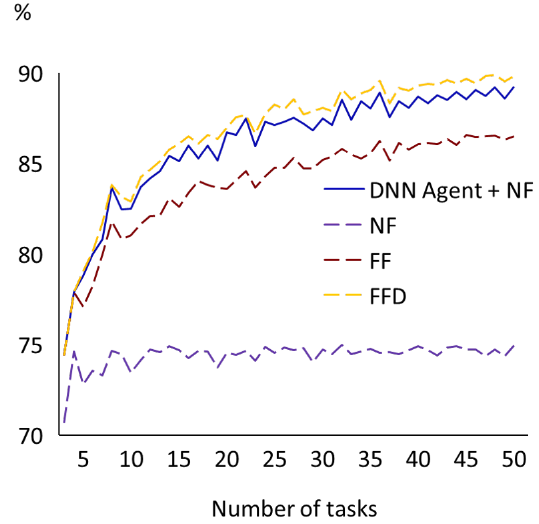
Figure 11. Problem 4 results by size of the input set of tasks. Average occupancy ratio